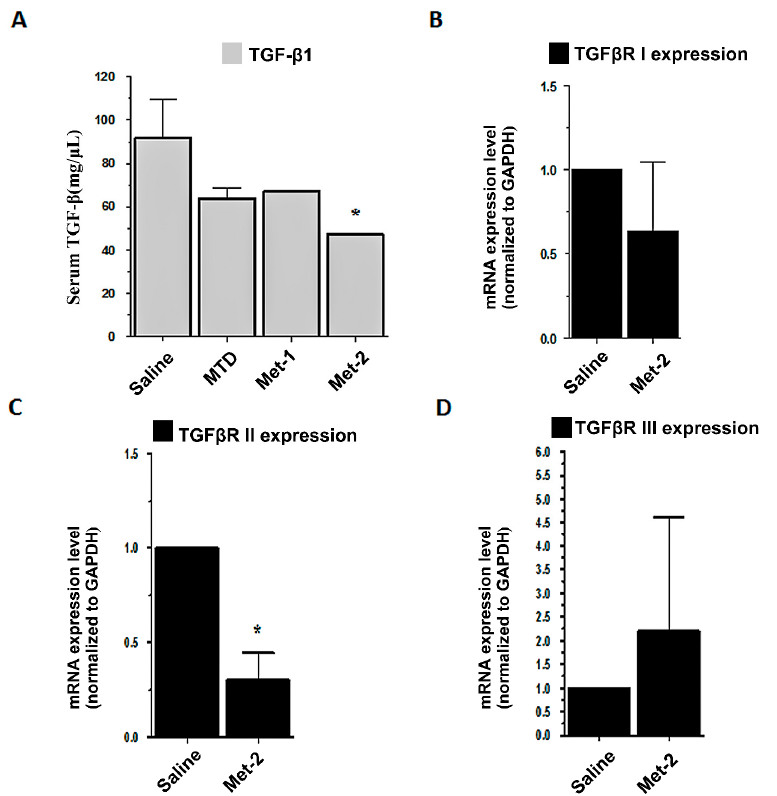
Figure 8. Implication of TGF- β signaling pathway in low cyclophosphamide activity. ( A ) ELISA analysis for serum TGF- β 1; ( B – D ) qPCR analysis for mRNA expression of TGF β RI, TGF β RII, and TGF β RIII, respectively. Serum was extracted after blood collection and tumors were collected; total RNA was isolated, then qPCR was performed, as previously described, * p < 0.05.